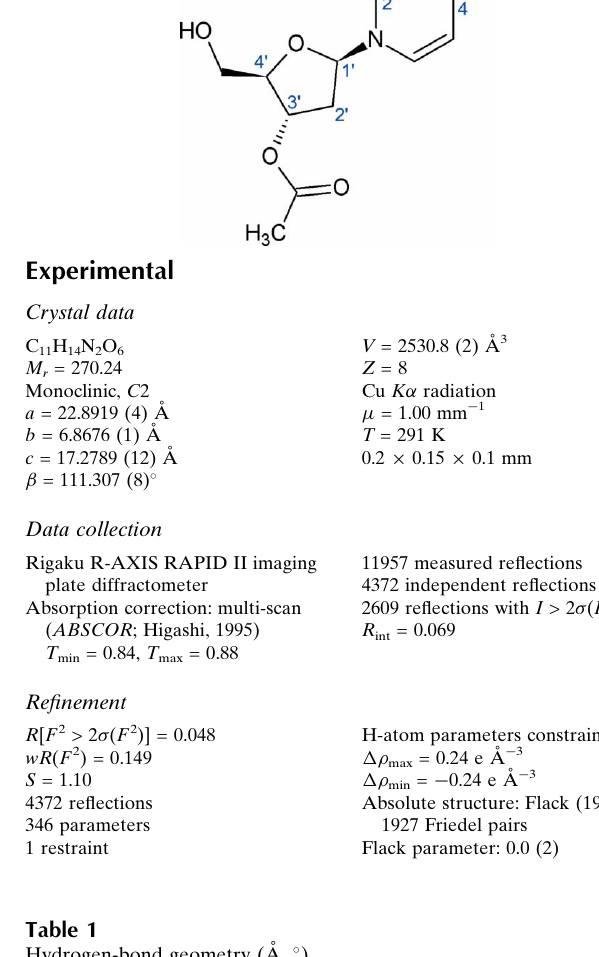
Hydrogen-bond geometry (A˚ , (cid:3)